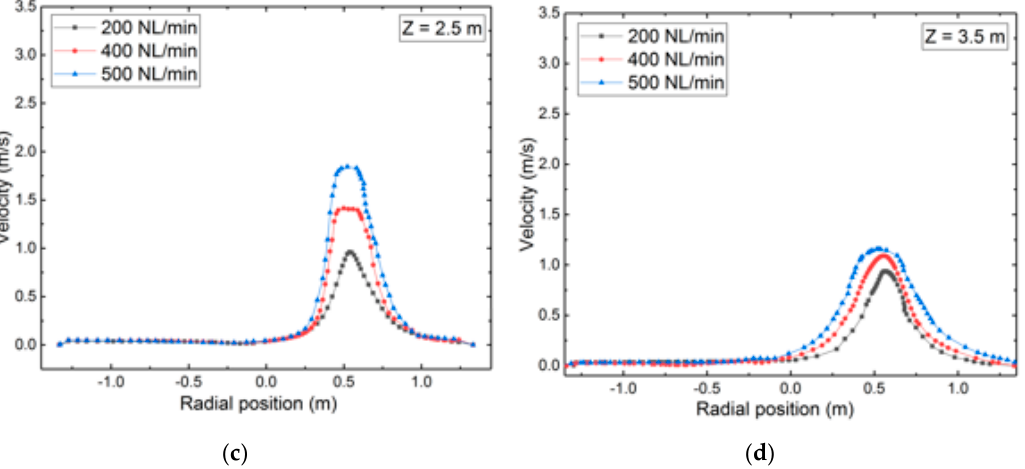
Figure 7. Simulation results of time-averaged flow velocity profiles in the ladle furnace for different gas flow rates at different heights: ( a ) Z = 0.5 m, ( b ) Z = 1.5 m, ( c ) Z = 2.5 m, and ( d ) Z = 3.5 m. Krishnapisharody and Irons [6] developed a mechanistic model for measuring the dimensionless open-eye size. The dimensionless open-eye area is expressed in terms of Froude number, which is further modified into the following correlation. [31]